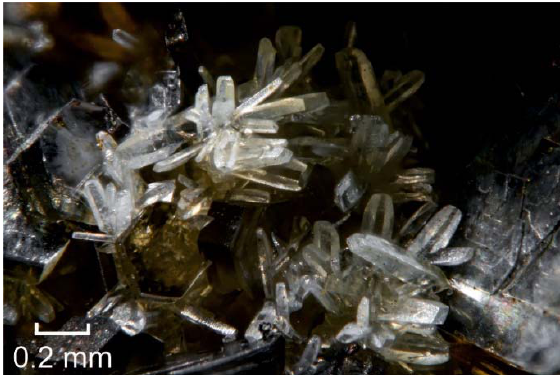
Figure 1. Crystals of hingganite ‐ (Y) from the Wanni glacier.